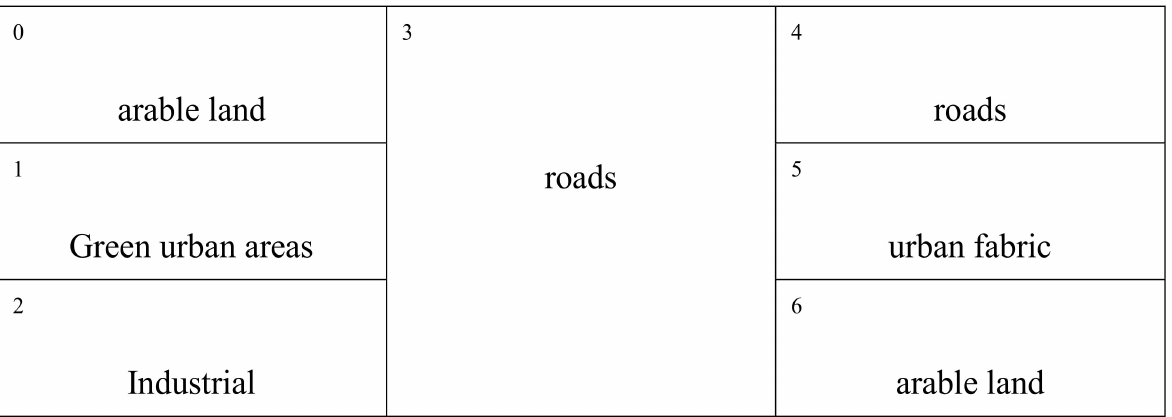
Figure 8. An example of the land-use